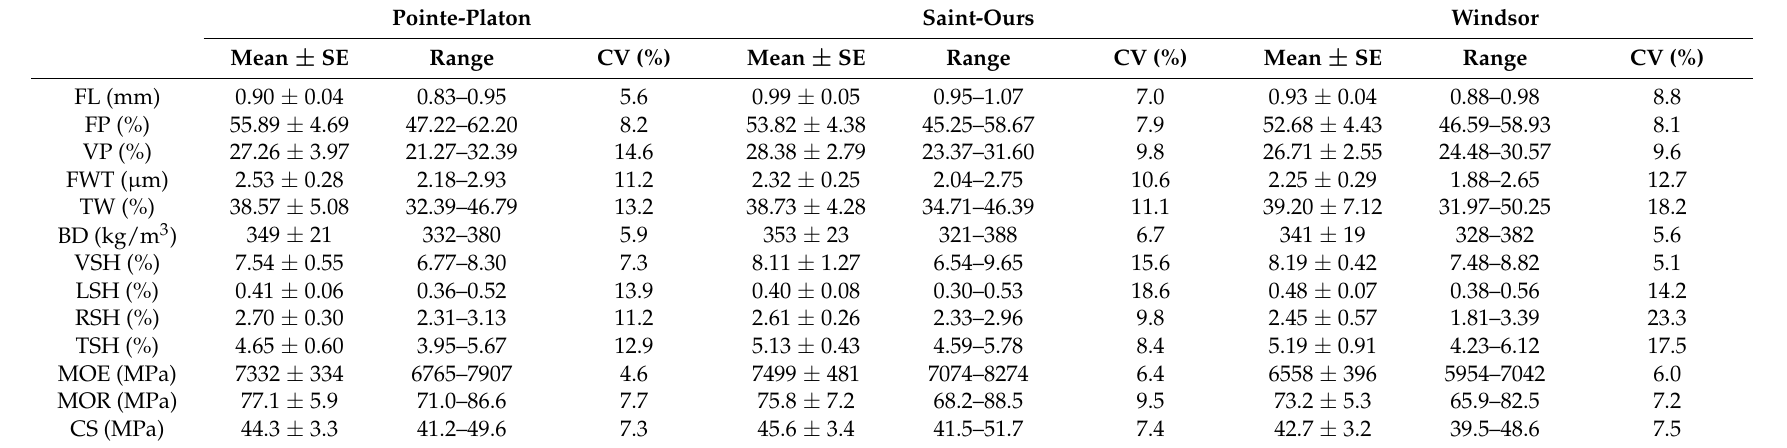
Table 3. Descriptive statistics of wood properties of hybrid poplar clones at the three